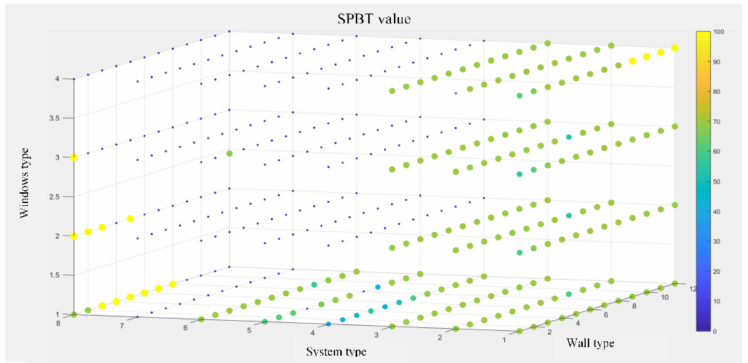
Figure 5. The values of the SPBT objective function in the space of decision variables (wall type, window type, and system type).